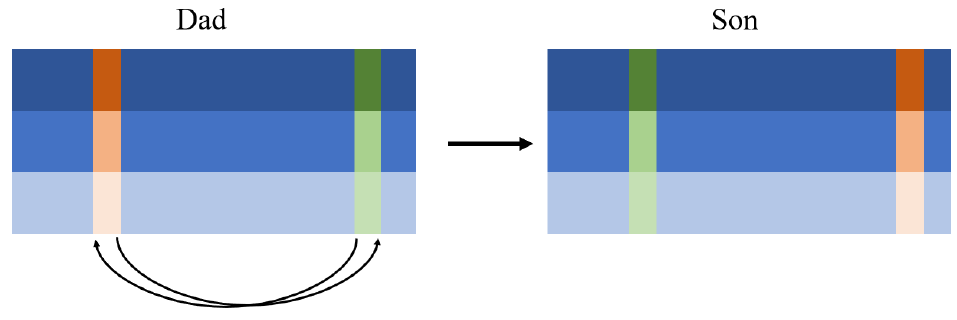
Figure 7. Graphical representation of the mutation genetic operator in the mGA.